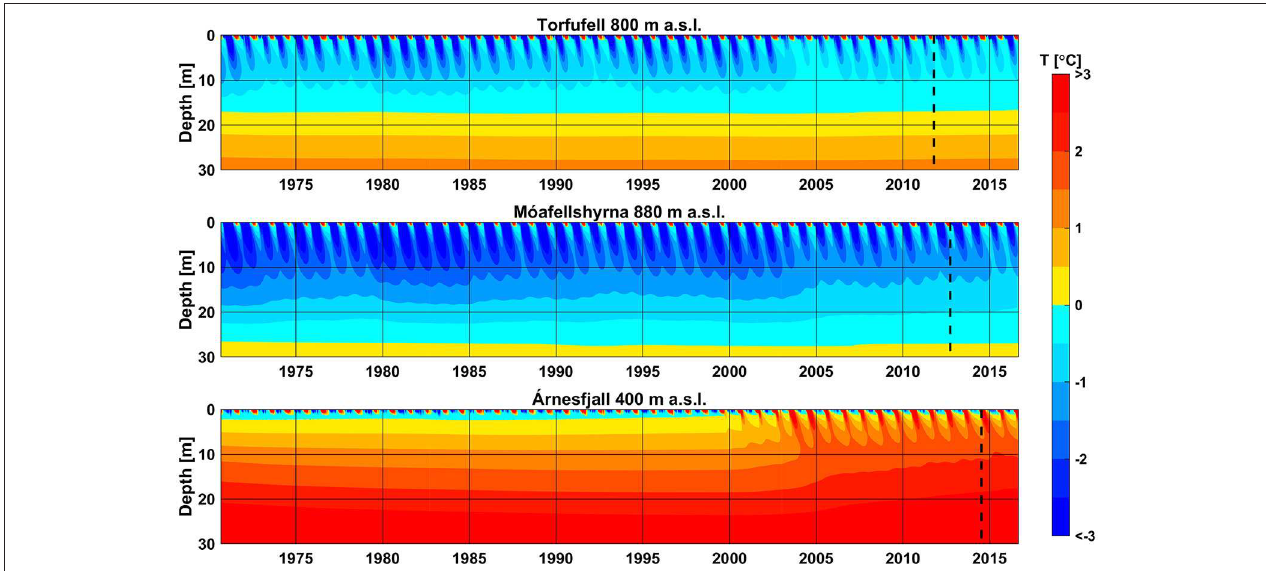
FIGURE 12 | Evolution of ground temperature for the source areas of the landslides with ice-cemented debris in the period 1970–2016. Lapse rate of 0.0065 ◦ C m − 1 was used to correct for elevation differences between the elevation of the source areas and elevation of the gridded air temperature [following recommendations in Crochet and Jóhannesson (2011)]. To account for that the source areas are steep (45–60 ◦ ) and do not accumulate much snow, precipitation fraction of 0.1 was applied in the modelling. Ground stratigraphy of Leptosols (see Table 1 ) was assumed. The dashed lines indicate dates of the landslides. Torfufell Mountain in north Iceland (14.10.2011) with a source area at an elevation of ∼ 800m a.s.l., (2) Móafellshyrna Mountain in the Tröllaskagi area (20.09.2012) with a source area at an elevation of ∼ 880m a.s.l., and (3) Árnesfjall Mountain in Westfjords